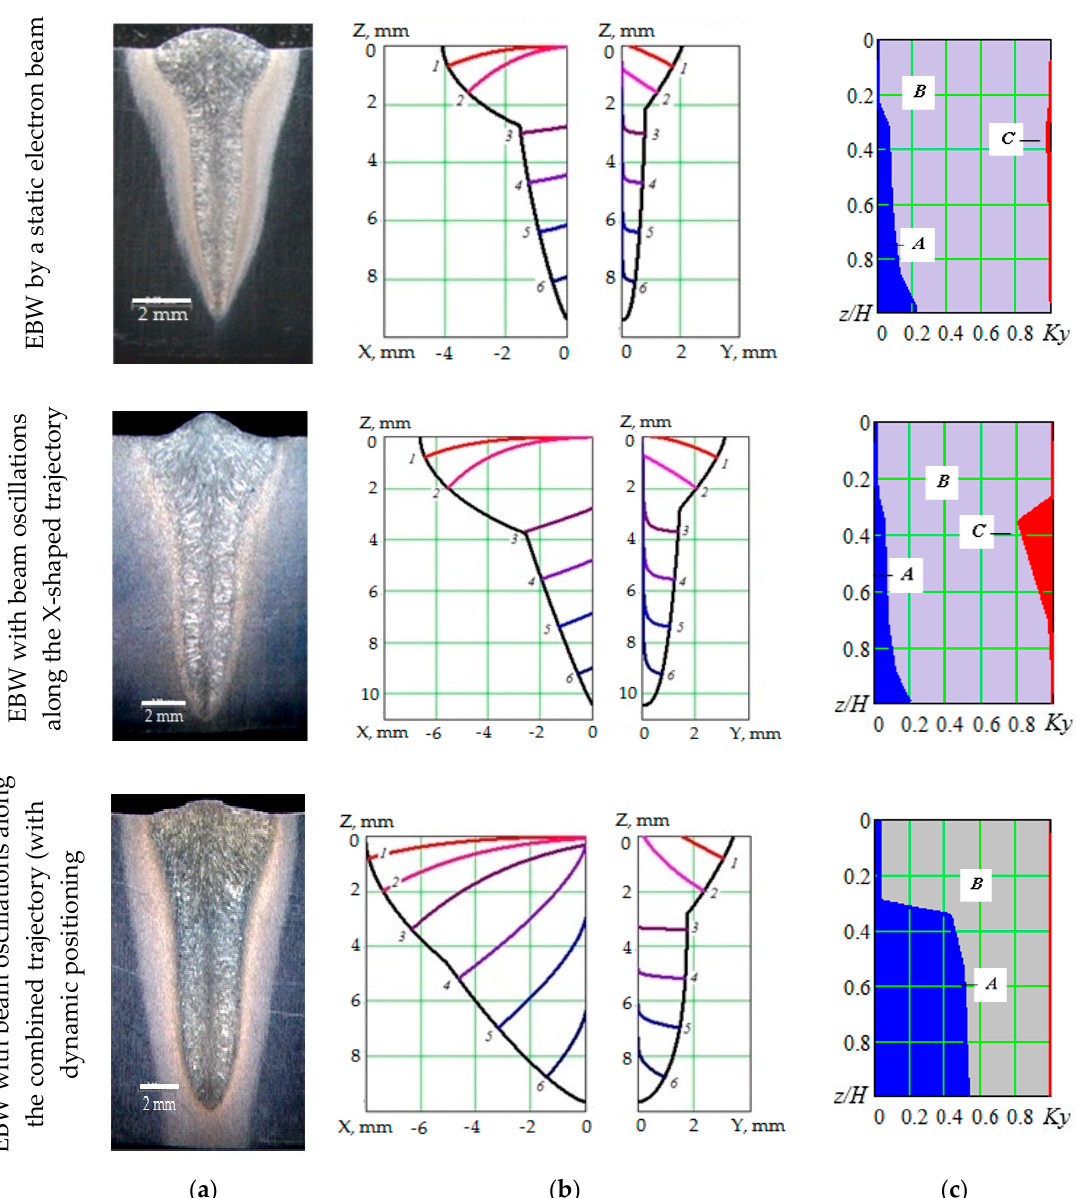
Figure 5. Weld macrostructure ( a ), shape of the crystallizing part of the welding bath with crystallite axis projections in the XOZ and YOZ coordinate planes ( b ), and diagrams of changes in macrostructure shape and crystallization pattern in provisional coordinates in the z/H depth and in the Ky = y/y 0 ( c ) weld width: (A—equiaxial structure, B—spatial growth of columnar crystallites, C—flat growth of columnar crystallites).